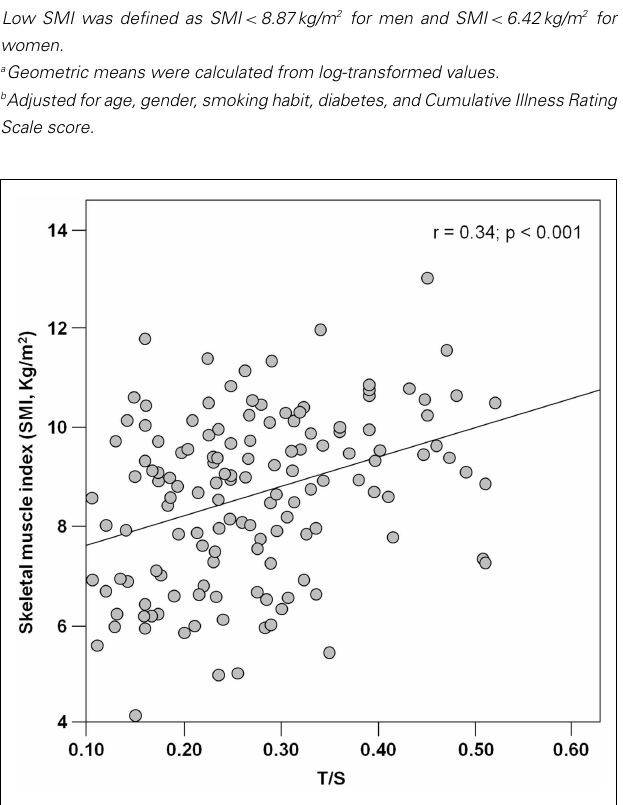
adjusted analyses, regardless of the frailty assessment tool adopted ( Table 4 ). Finally, no significant correlations were determined between T/S values and any of the five domains defining PF (data not